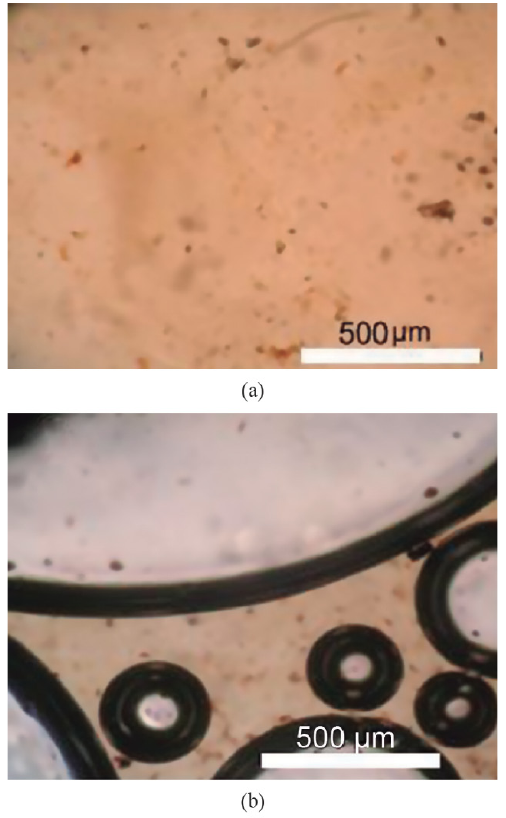
Figure 3. OM images of PET/PC (80/20 wt/wt%) (exposed 2000 h): a) 25 °C; b) 280